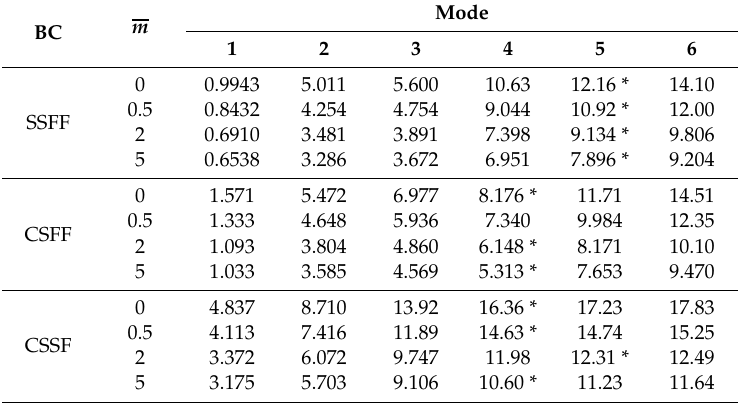
Table 10. Nondimensional natural frequencies Ω of FGM square plates ( h / a = 0.1) with SSFF, CSFF, CSSF, CCFF and CCCF boundary conditions; “*” denotes the in-plane displacement-dominated